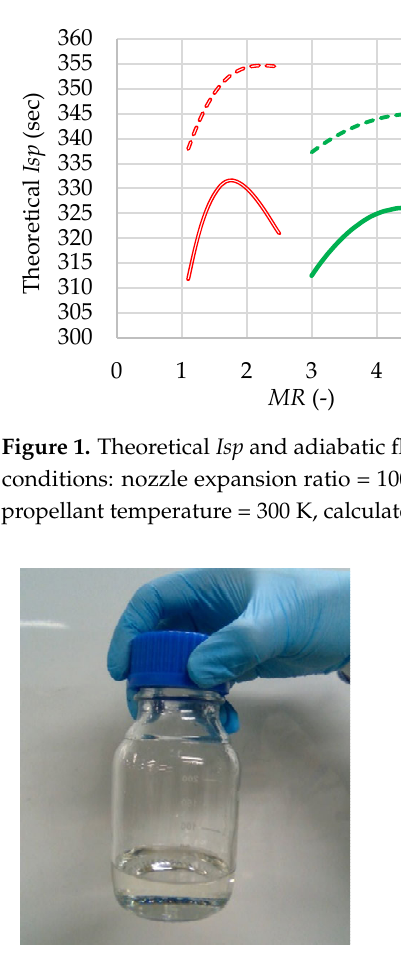
(*) Calculated by CEA [18] (conditions: nozzle expansion ratio = 100, frozen flow at throat, initial chamber pressure = 10 atm, propellant temperature = 300 K).